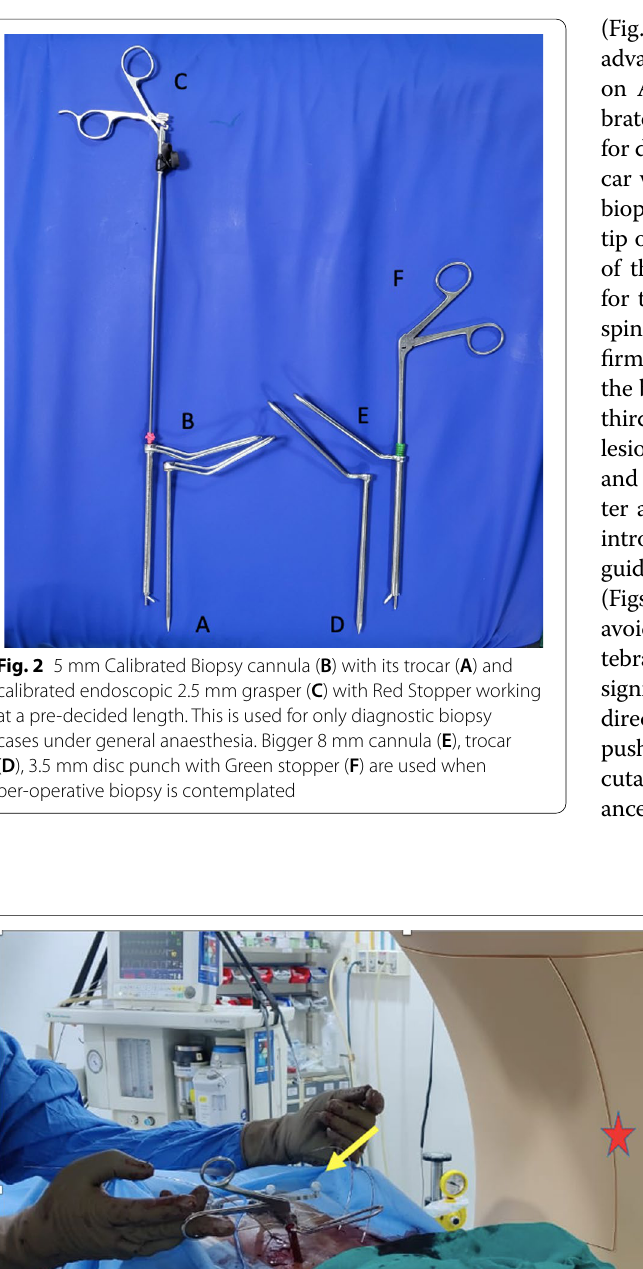
Fig. 3 A O Arm being used for 2D confirmation (Red star) and navigation patient frame(yellow) with the calibrated biopsy cannula housing the disc punch with a stopper. B , C The 2D image taken to After Navigated Positioning of guide wires for screw and Biopsy cannula, confirms the position of the tip of cannula which is beyond the neural canal margin. D , E Final 5 screws percutaneous Sextant (Medtronic) Fixation